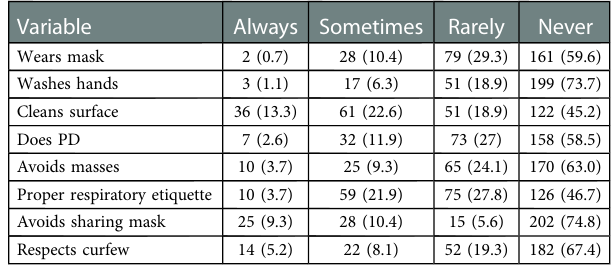
Values are given as n (%). PD, physical distancing.